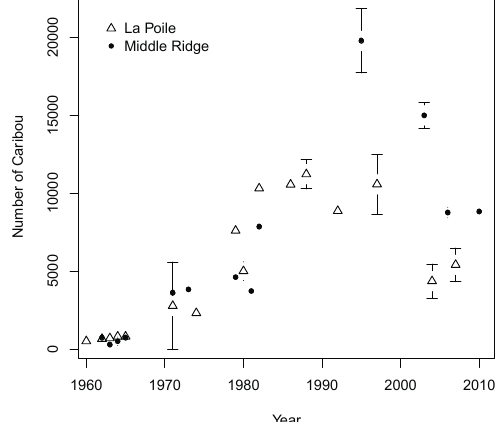
Fig. 1. Estimated population size of the La Poile and Middle Ridge caribou herds, Newfoundland, 1960 to 2010 based on aerial and ground censuses. Bars represent 90% confidence intervals.